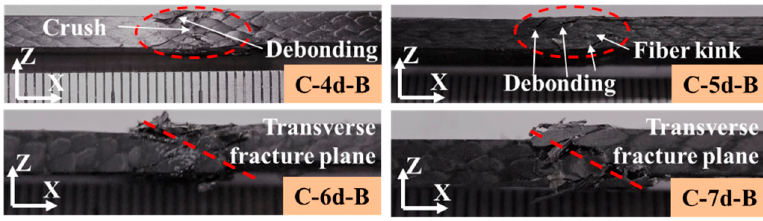
Figure 13. Compressive failure of 3DBC with a braiding angle of 20°.